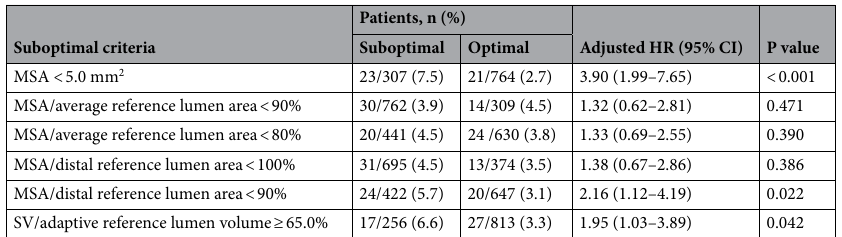
Suboptimal criteria